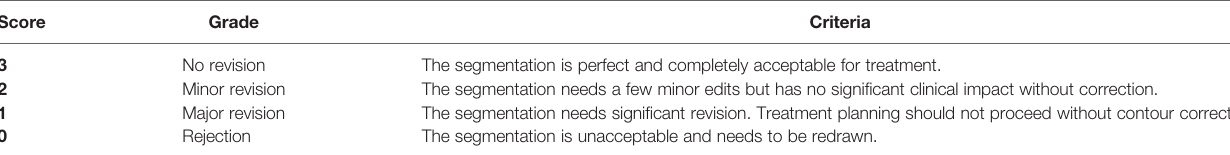
TABLE 1 | Criteria for the radiation oncologist evaluation. Score Grade